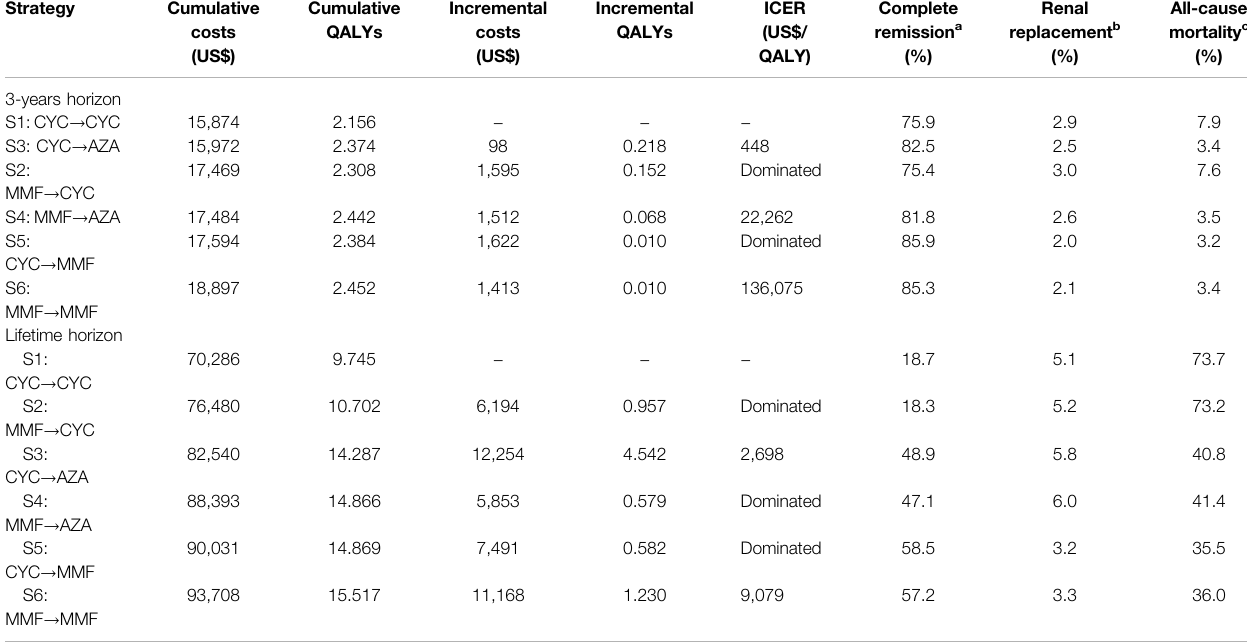
TABLE 2 | Base-case cost-effectiveness outcomes of different strategies for LN treatment, and predicted cumulative incidence of complete remission, renal replacement and all-cause mortality. Strategy